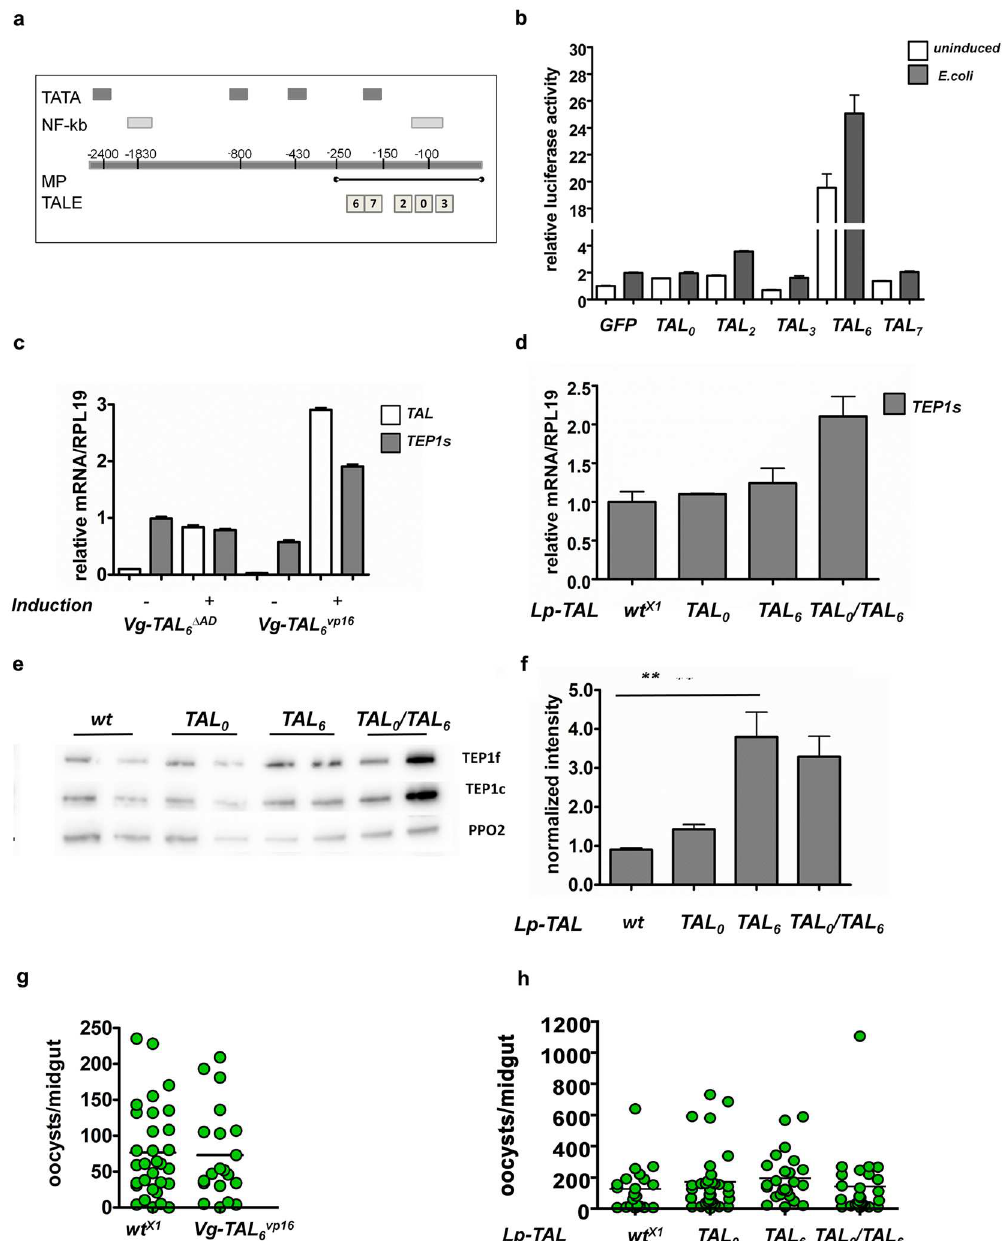
Fig 7. Synthetic TALE transcription factors targeting the TEP1 promoter. a . Schematicrepresentation of the ~3Kb TEP1 promoter (not to scale). Shownare potentialNF- κ B sites (GGGRNNYYCC) (light grey boxes) and potential TATA boxes (dark grey boxes). The minimalpromoter (MP) shownto be active in cells is indicatedby a black line. Numbers on the promoter indicatethe distancefrom the ATG. White boxes represent the bindingposition of each designedTALE. b . Luciferase assay in S2 cells showingthe effect of TALEs on the minimal TEP1 promoter. Different TALE constructs all carrying a VP16 activationdomainand placed under the Drosophila actin5c promoter were co-transfected into S2 cells together with a firefly luciferase reporter gene under control of the minimal TEP1 promoter. A plasmidcarrying GFP placed under the same promoteras TALEs was used as reference for basal promoteractivity. The TEP1 promoter was further inducedby additionof heat killed E . coli to the cells. Luciferase activity was normalizedto the basal promoter activity without TALEs. c . qRT-PCR to assess the level of TALE and TEP1 mRNA in transgenic mosquitoesexpressing Vg-TAL 6 comparingfunctionalTALE with VP16 activation domain( Vg-TAL 6vp16 ) and control line expressingthe same TALE without activationdomain( Vg-TAL 6 Δ AD ), with or without inductionof the Vg promoter by a blood meal 24h prior to mRNA extraction. d. qRT-PCR of